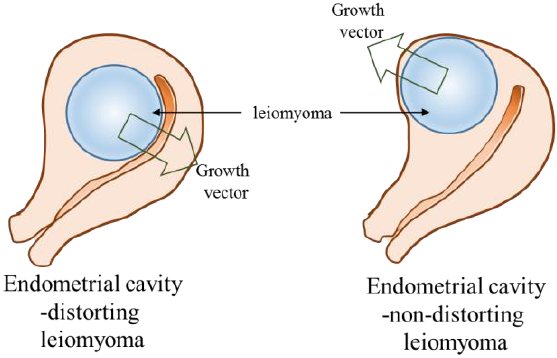
Figure 8. Diagram of endometrial cavity-distorting and endometrial cavity-non-distorting leiomyoma in intramural uterine leiomyoma (arrow: growth vector).